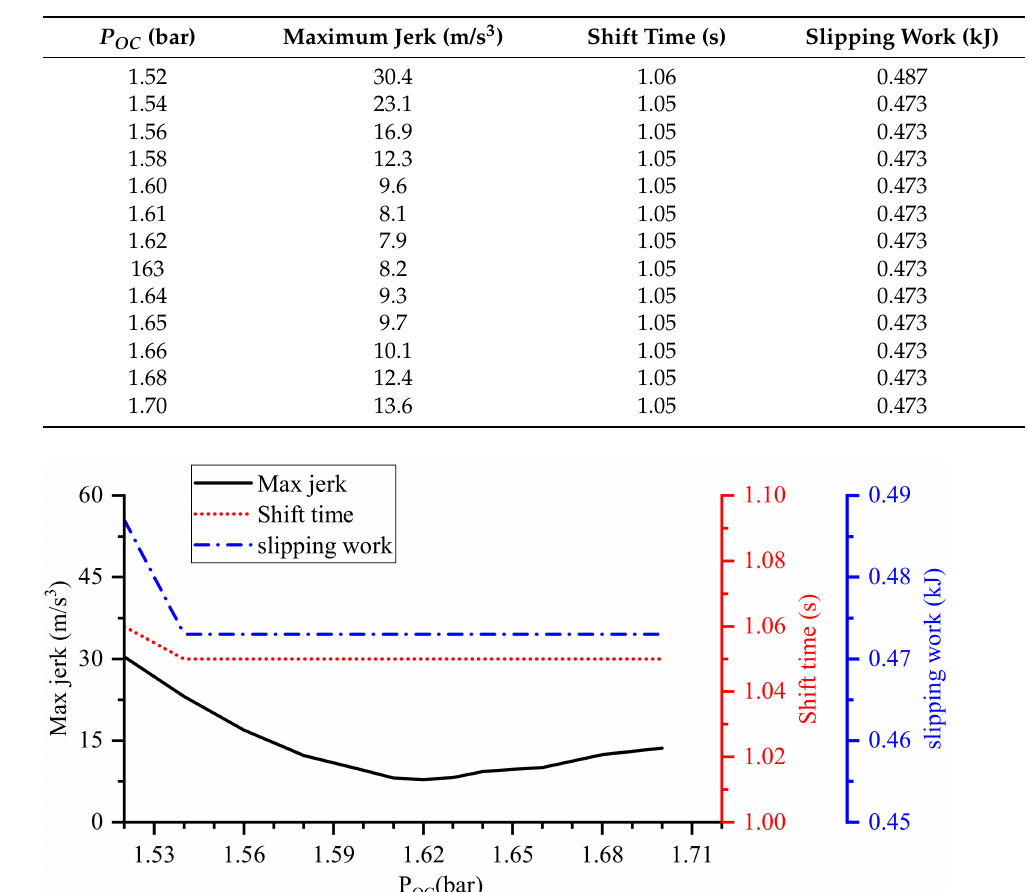
Figure 15. Variation of shift evaluating indexes under different P OC .